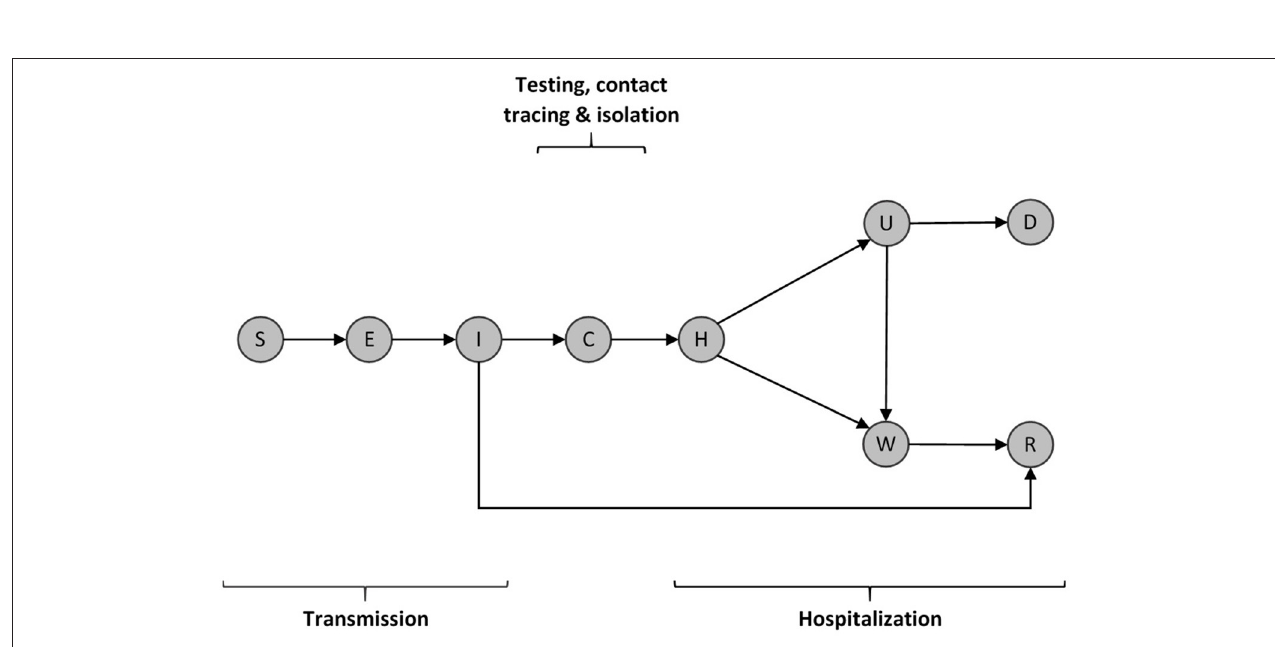
FIGURE 2 | Schematic diagram of the COVID-19 transmission model. Individuals (S) susceptible to the virus become infected by infectious individuals (I). They then move through a latent period (E) before becoming infectious (I). Infectious individuals can either move through a detection period (C) or eventually recover without symptoms. Confirmed infectious individuals move through an initial hospitalization period (H) after which they are admitted to either an isolation ward (W) or an intensive care unit (U). Intensive care patients may recover and be sent to an isolation ward W or ultimately die (D). Isolated patients move through a recovery period (R), where they are assumed to be immune to the disease, at least in the medium